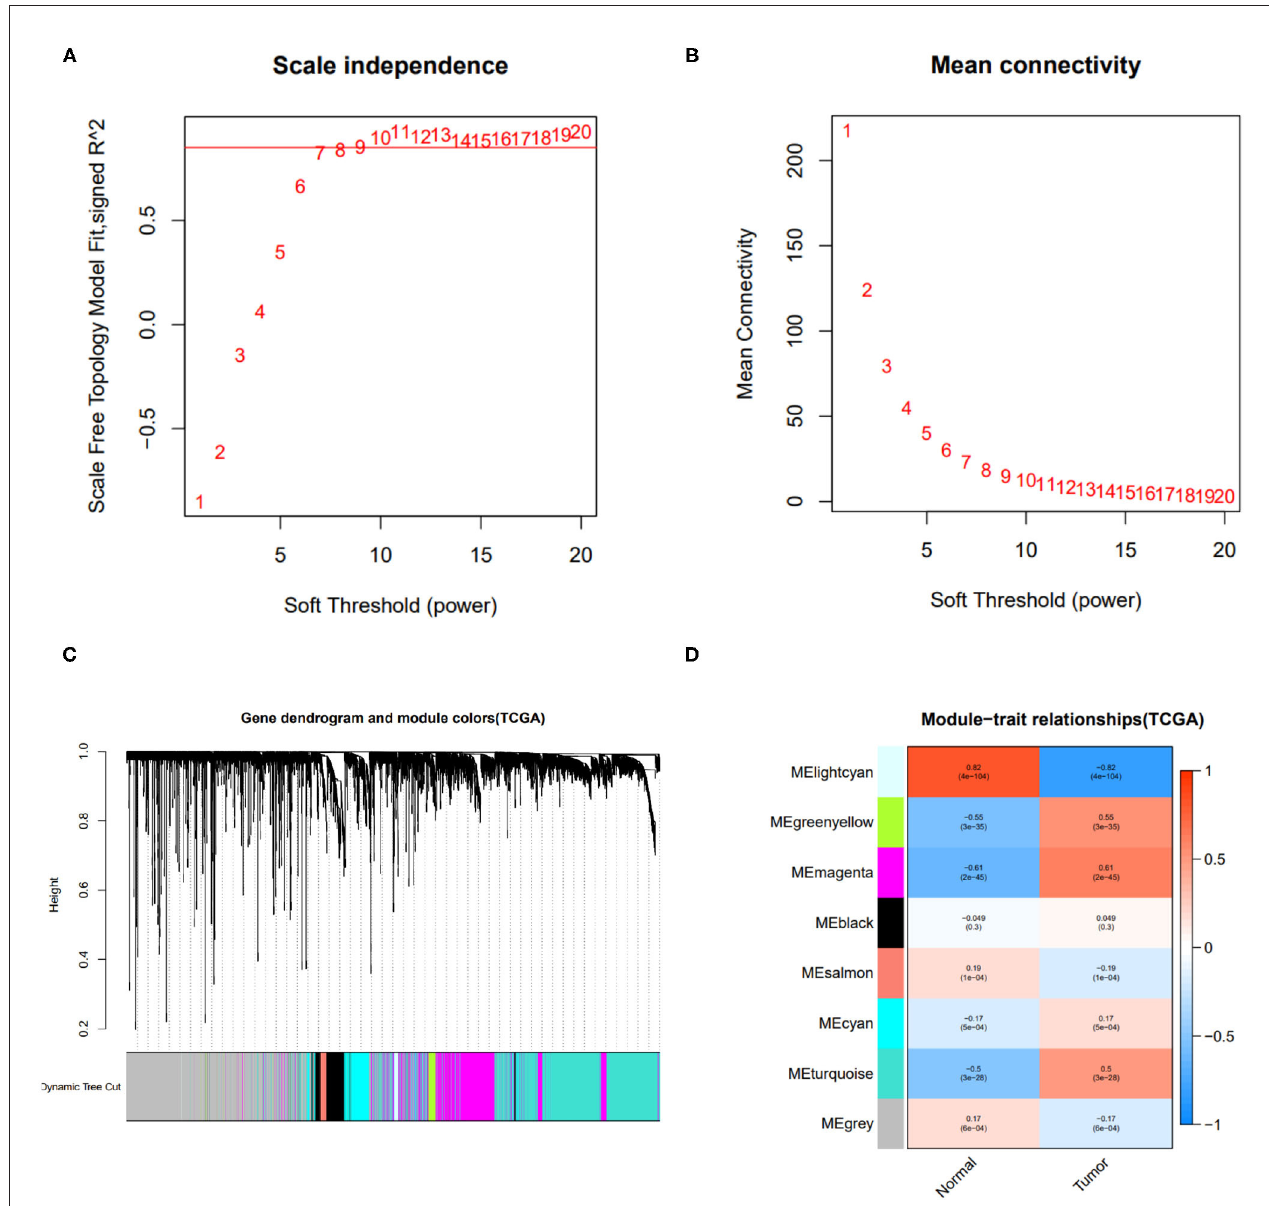
FIGURE 1 | Results of weighted gene co-expression network analysis (WGCNA). (A) The scale-free fit index of various soft-thresholding powers. (B) Mean connectivity of various soft-thresholding powers. (C) A dendrogram of the differentially expressed genes clustered based on different metrics. (D) Heatmap of associations between module eigengenes of normal and tumor